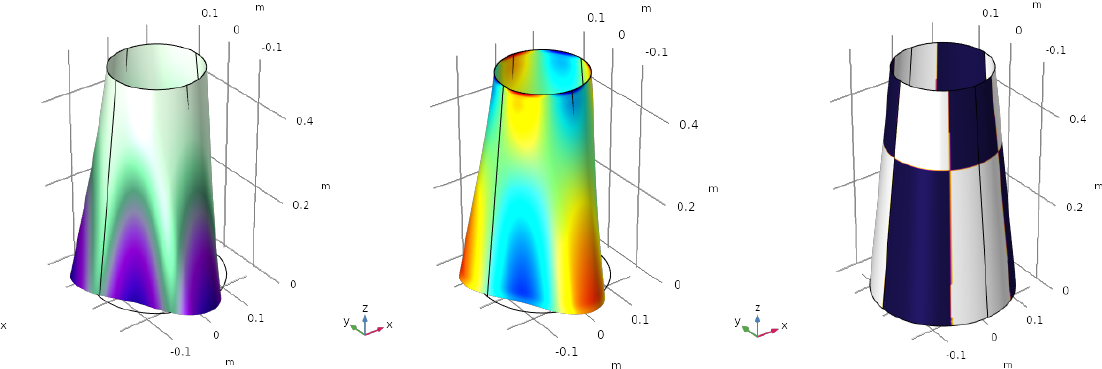
Figure 4. First vibration mode f 1 = 147 Hz. Mode shape ( left ), electric charge ( centre ) and optimized electrode profile ( right ).